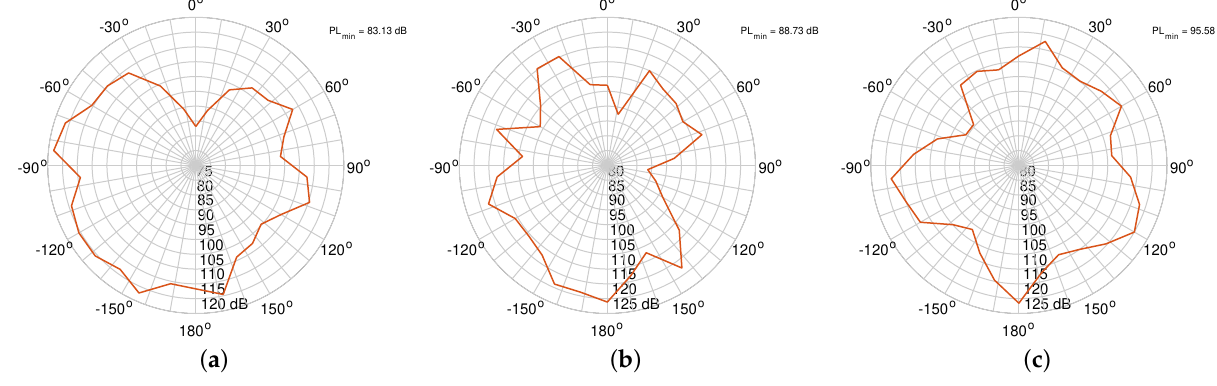
Figure 5. Angular path loss profiles at 60 GHz for Line-of-Sight (LOS) and non-Line-of-Sight (NLOS) scenarios. ( a ) LOS, distance 4.7 m; ( b ) NLOS, distance 4.7 m; ( c ) NLOS, distance 3.4 m.